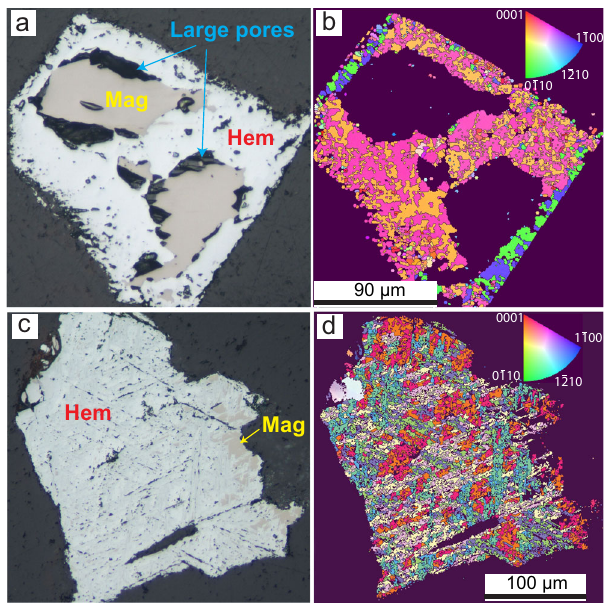
Fig. 1 Effect of cerium on the replacement textures. a , c Optical re fl ected light micrographs and b , d EBSD orientation maps. The reactions were conducted in oxidant-free Ce-bearing solutions ( a , b ) and in oxidant-free Nd-bearing solutions ( c , d ). a Hematite replaces magnetite along the rim; gaps occur at the hematite – magnetite interface; large (5 – 30 µ m) pores occur within hematite. b EBSD inversed pole fi gures map showing hematite crystal orientation and boundaries in a . c Hematite replaces magnetite from one side of the parent magnetite grain. Hematite forms lamellae that are in close contact with magnetite, with no visible pores at the interface. Small (<1 – 10 µ m) pores are present within the hematite. d EBSD inversed pole fi gures map showing hematite crystal orientation and grain boundaries in c